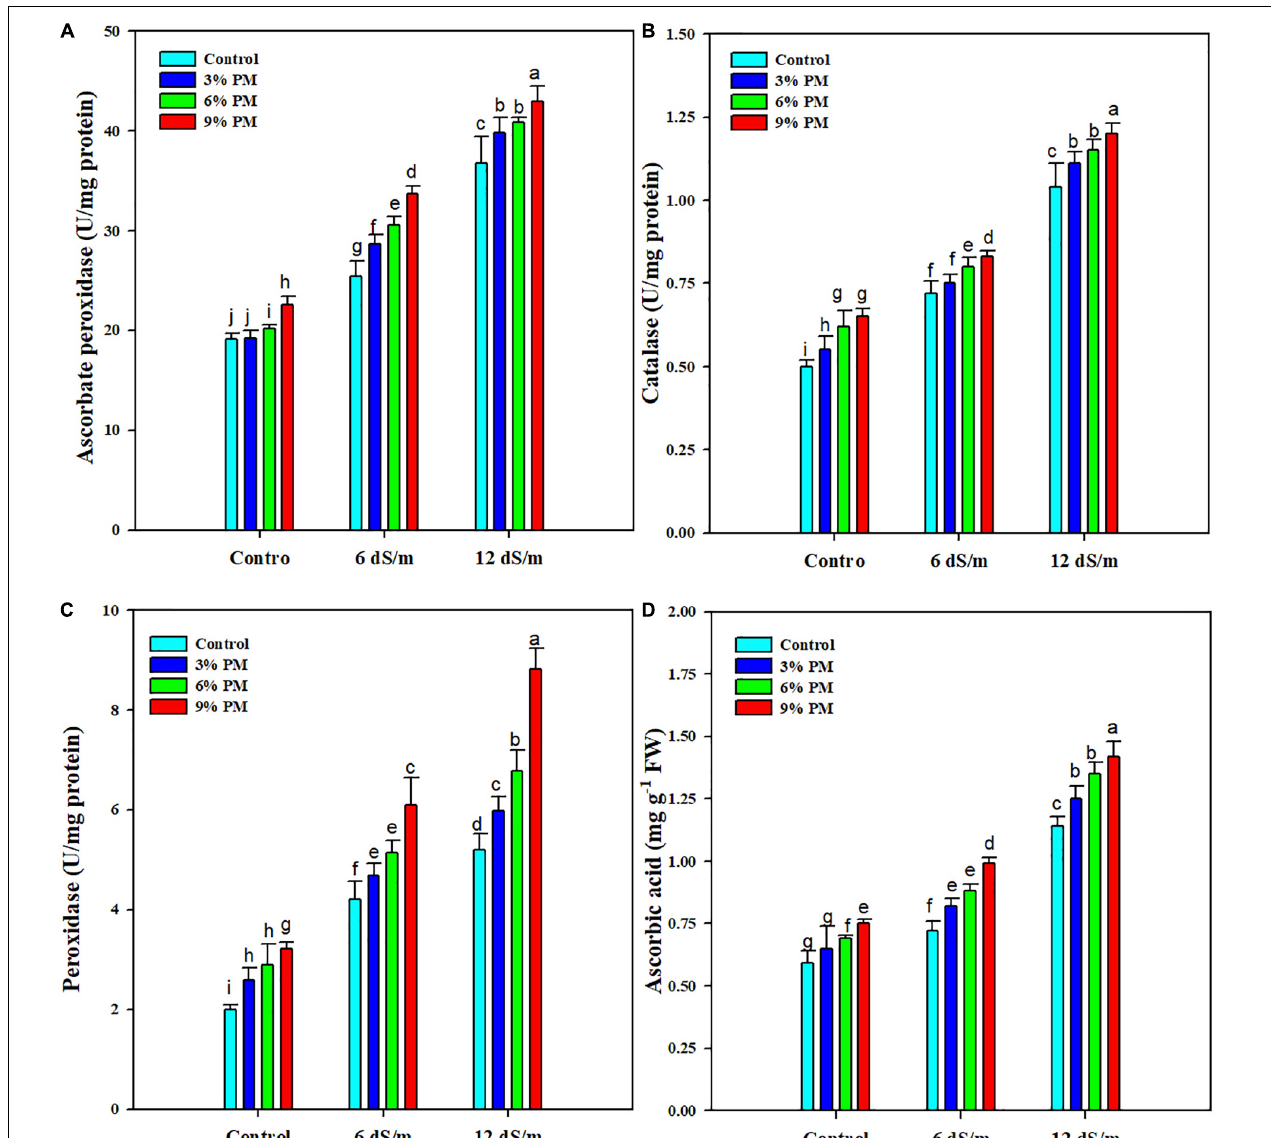
FIGURE 4 | Effect of different levels of press mud application on APX (A) , CTA (B) , POD (C) , and AsA (D) contents of rice crop grown under different levels of salinity stress. The bars indicate the means of three replications with ± S.E. and a different letter indicating significant differences at p <